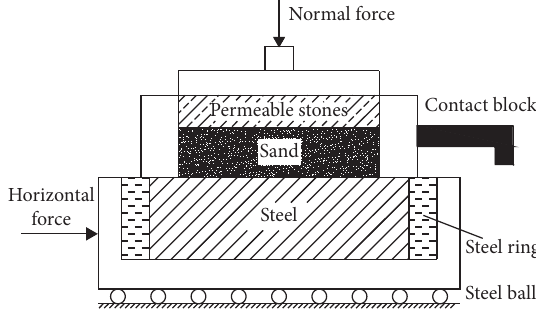
Figure 1: Improved direct shear apparatus sketch.